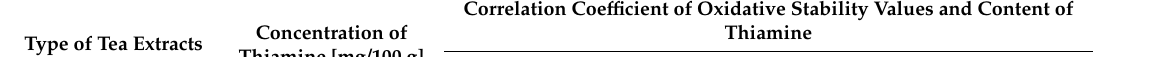
Table 4. Correlation coe ffi cients between the antiradical activity of tea extracts and the content of thiamine hydrochloride and thiamine